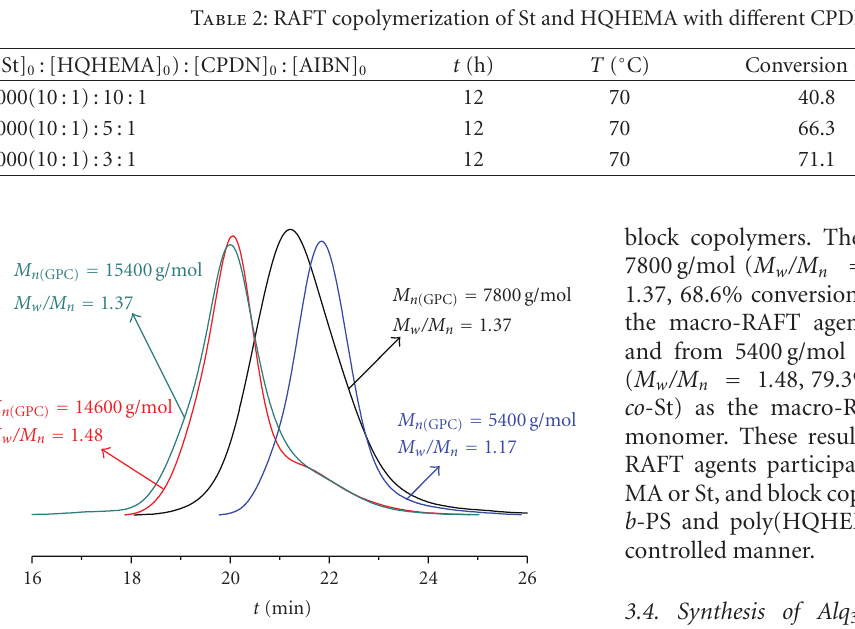
Figure 7: GPC curves of macro-RAFT agent (poly(HQHEMA- co -MMA) and poly(HQHEMA- co -St)) and polymers